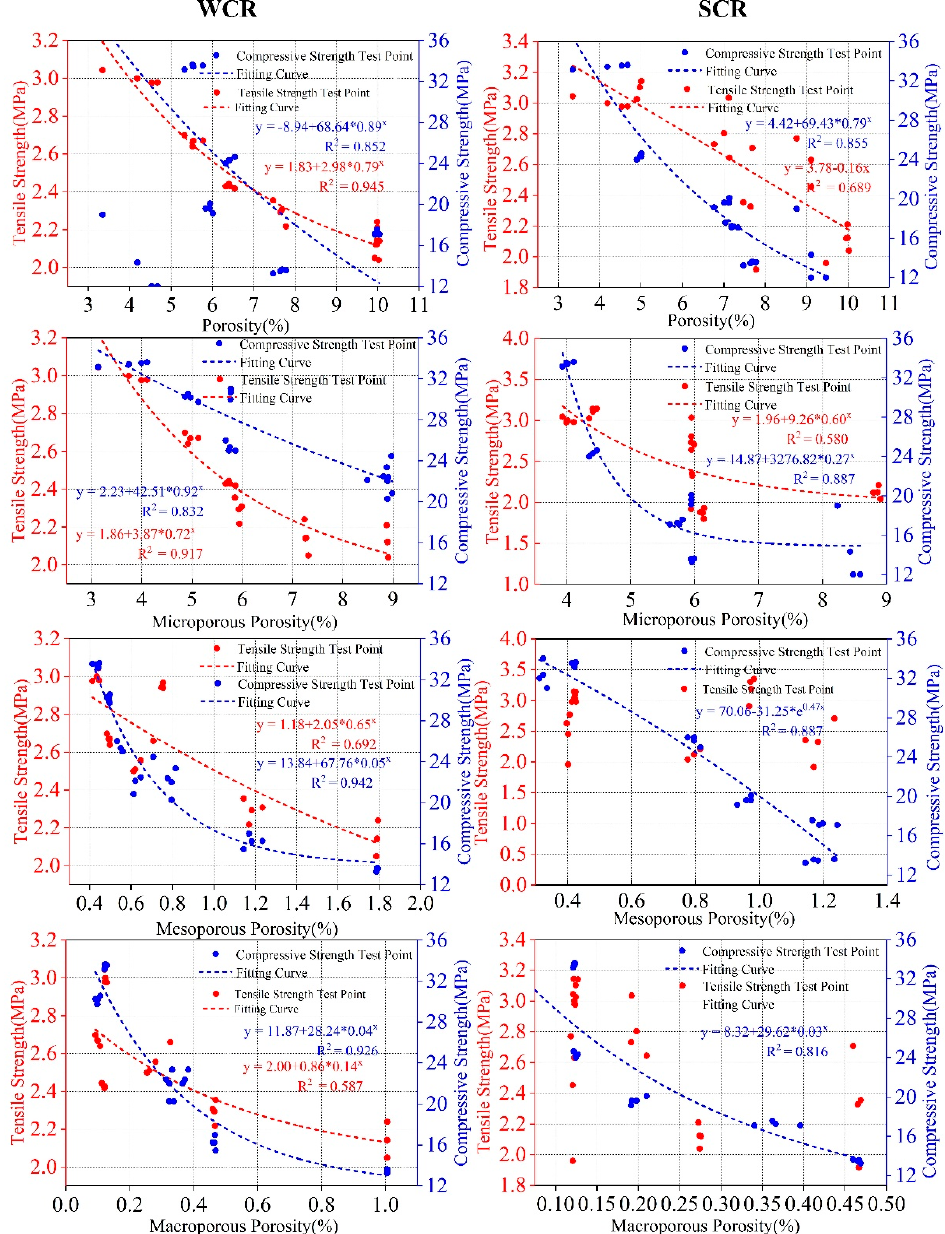
Figure 14. Fitting analysis of different porosity parameters and mechanical properties.